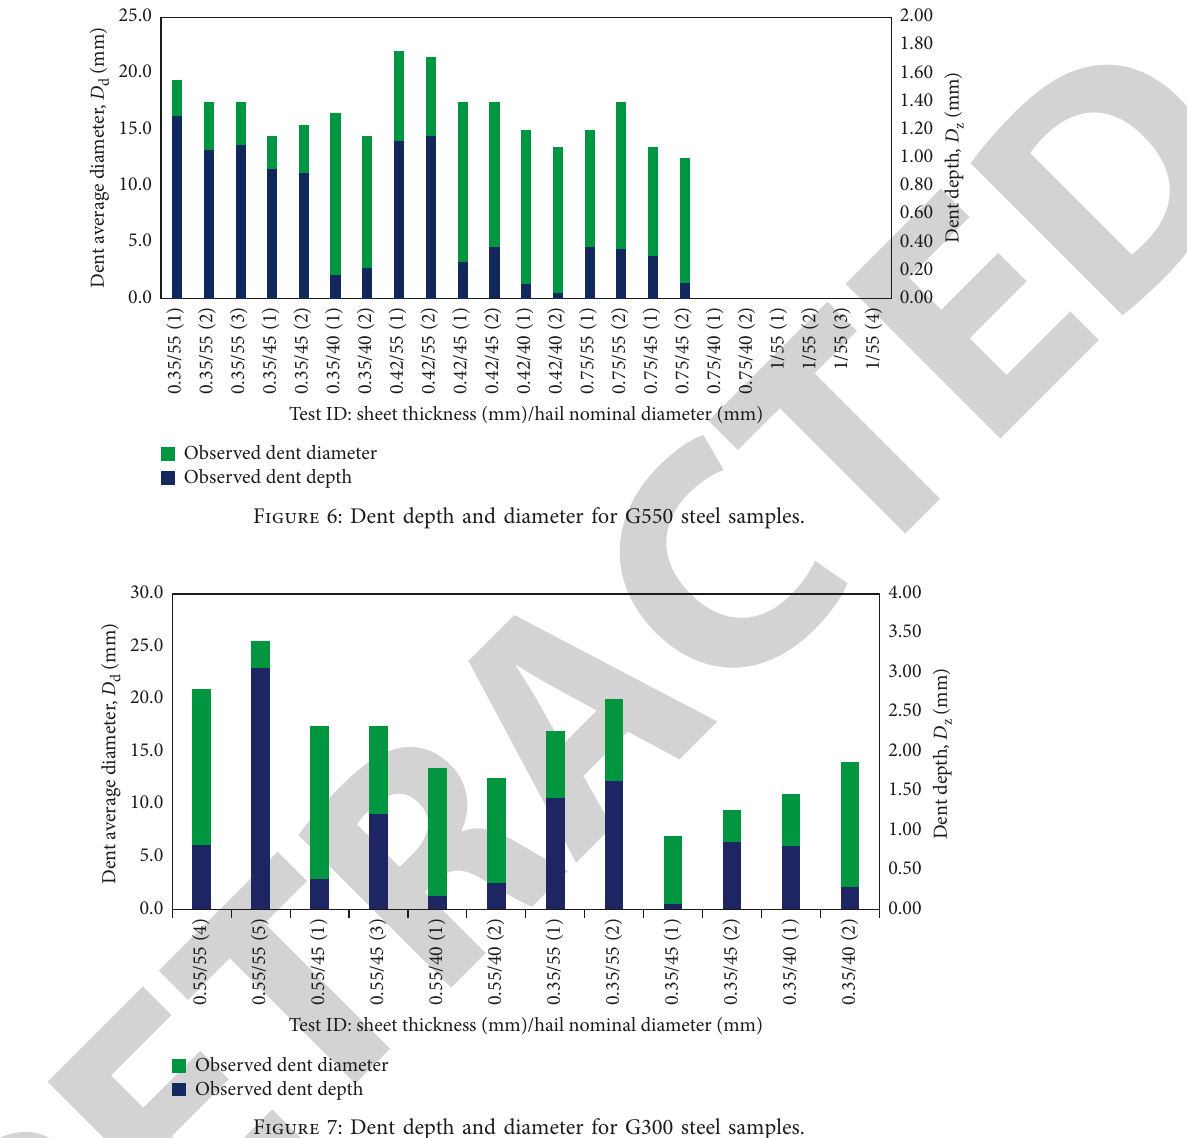
Figure 7: Dent depth and diameter for G300 steel